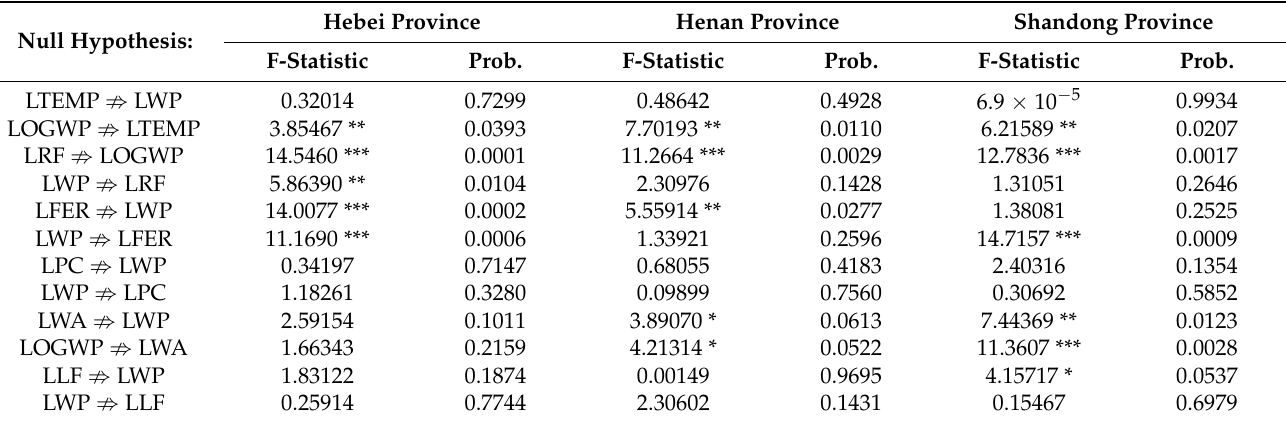
Table 6. Granger causality test outcomes for Hebei, Henan, and Shandong